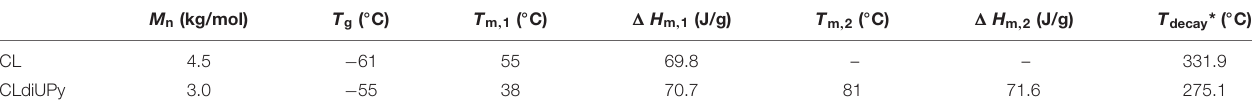
TABLE 1 | Thermal properties of PCL and